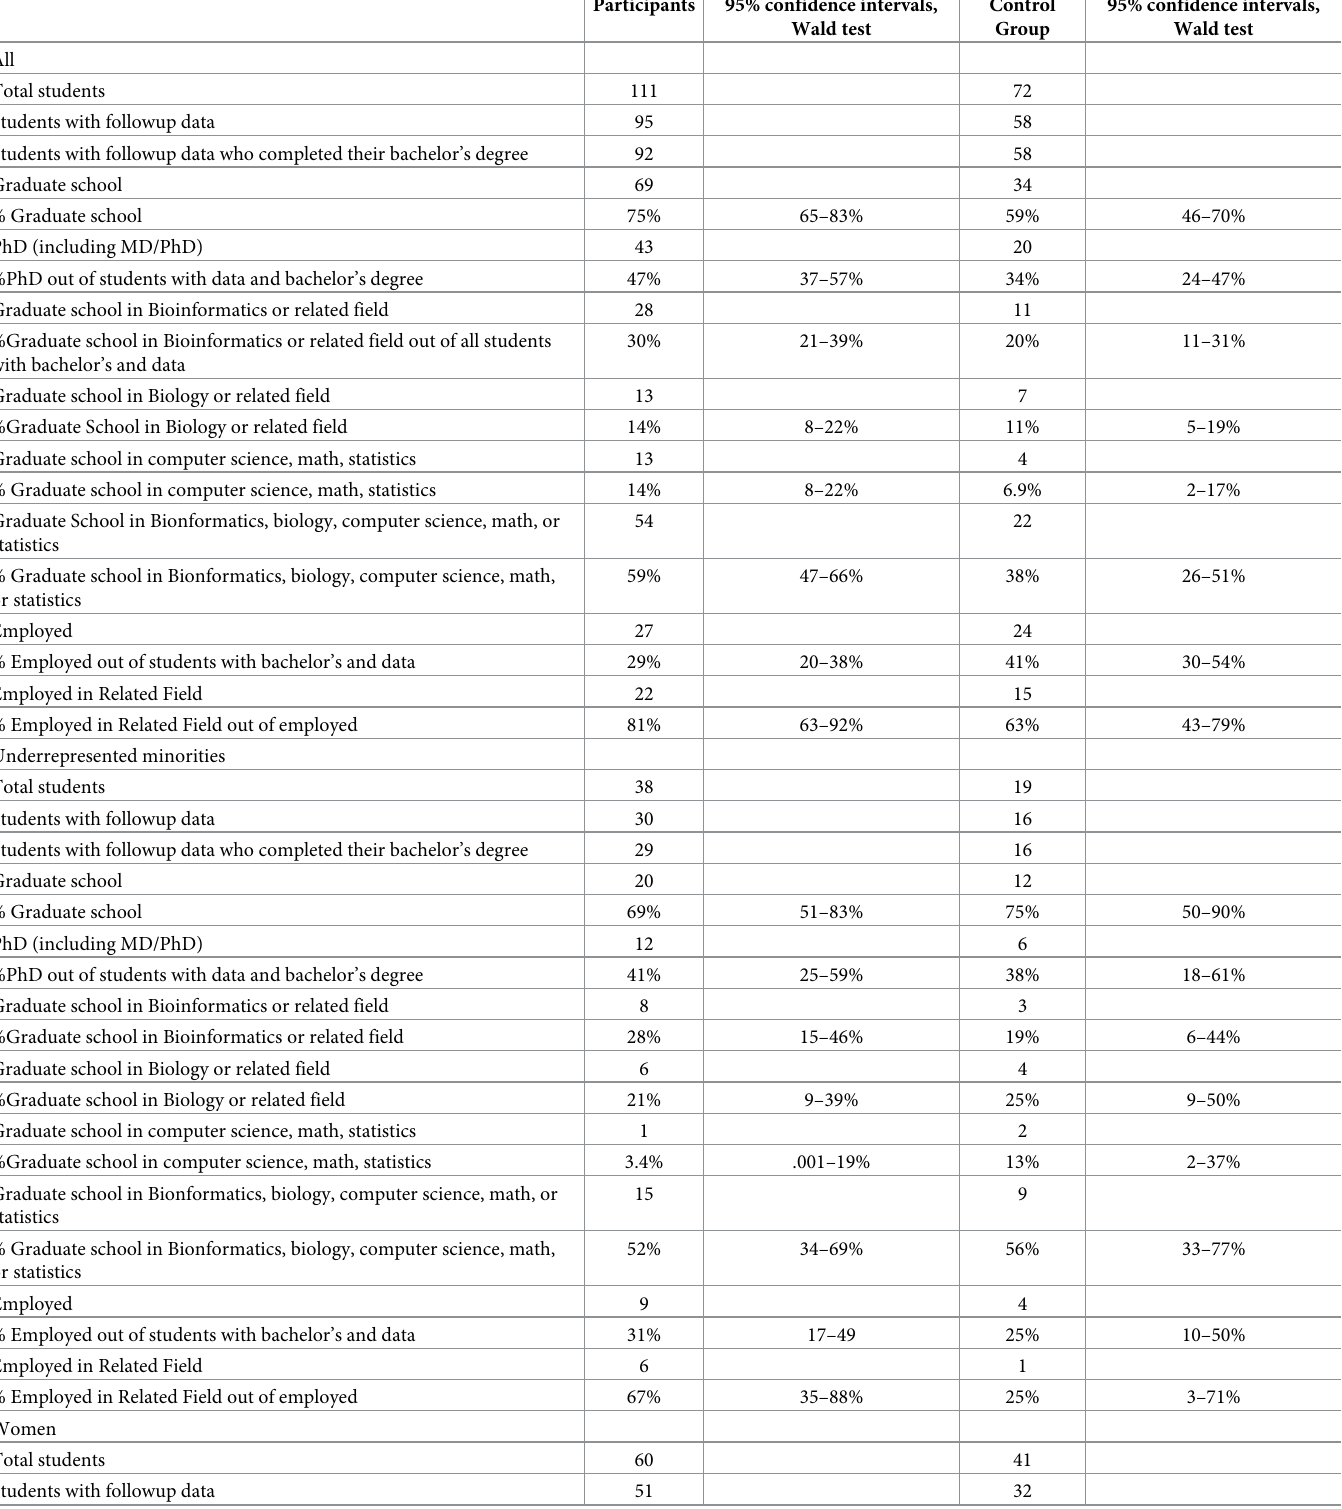
Table 2. Outcomes for BIG Summer participants and a control group of